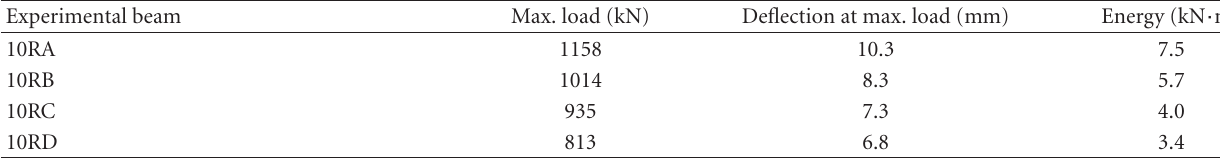
Table 1: Summary of experimental and finite element modeling results.